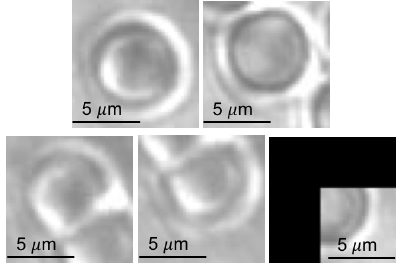
Figure 17. Examples of positive training samples for the convolutional neural